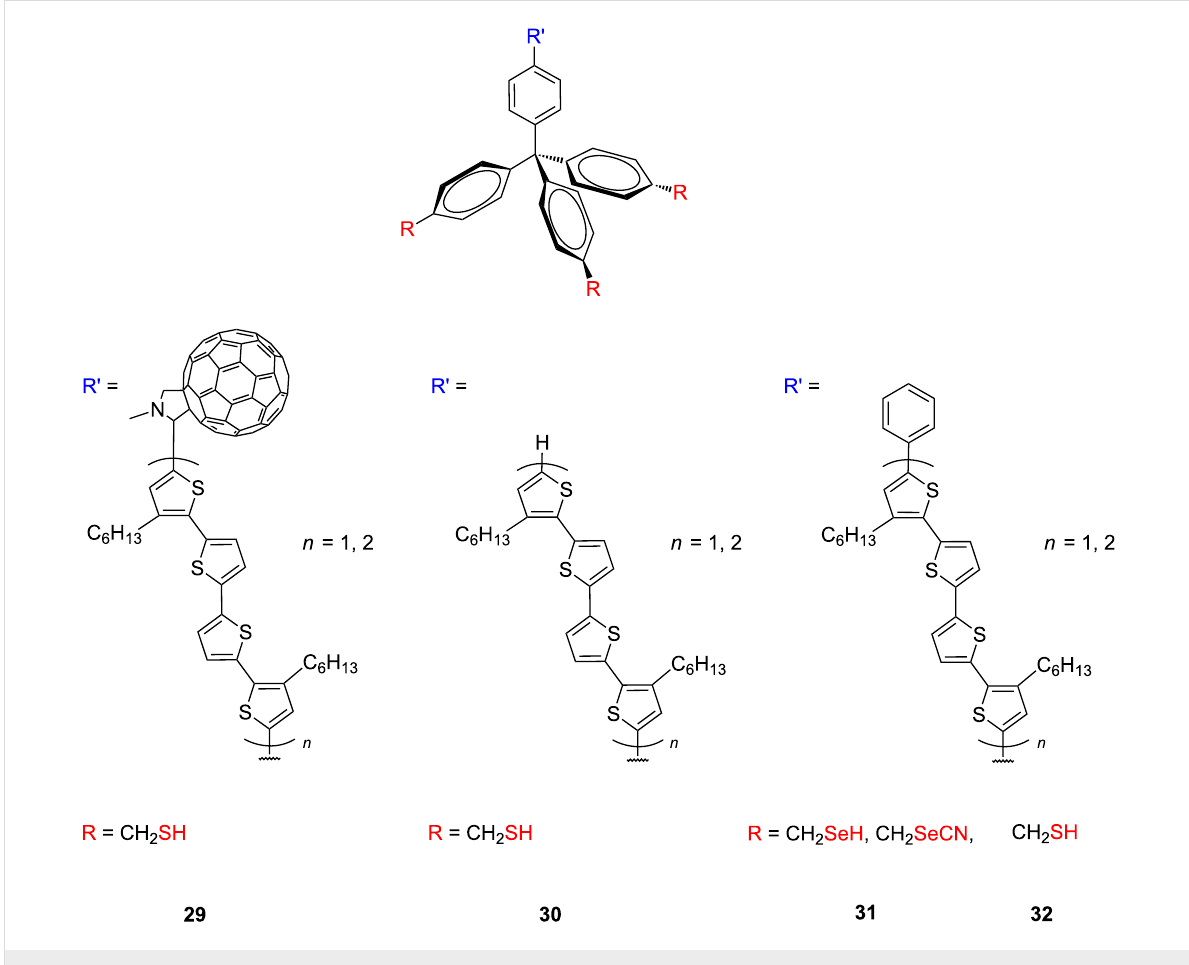
Figure 12: Functionalized tetraphenylmethane tripods 29–32 .